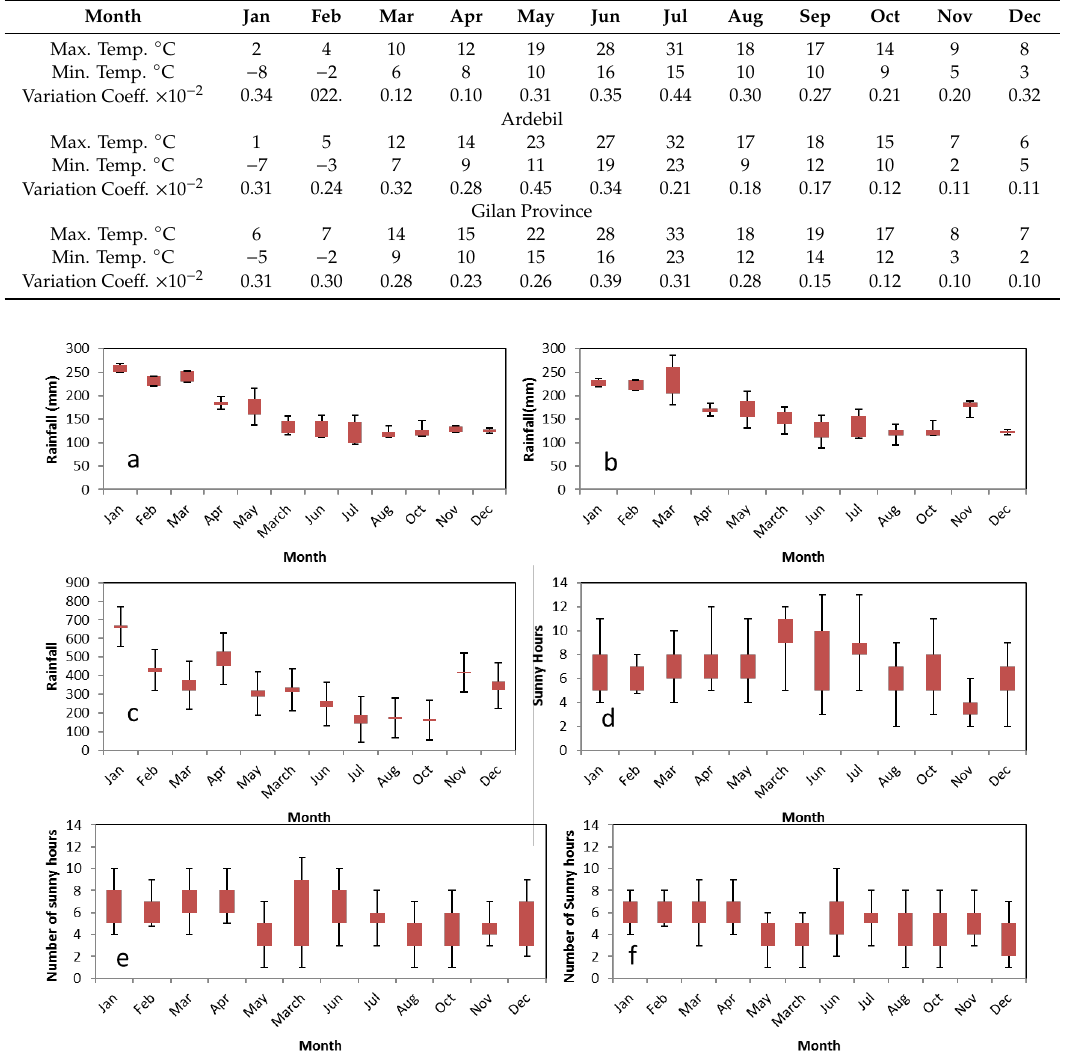
Table 2. Temperature variation for the di ff erent months (2008–2019).